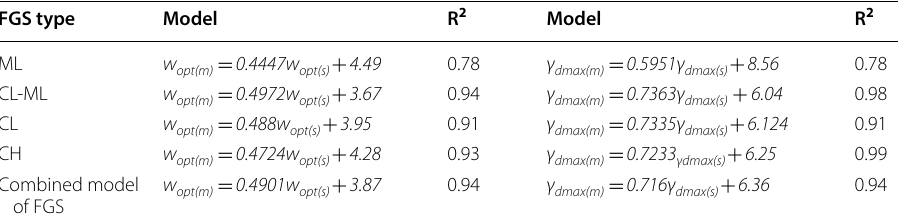
and γ ) opt(m) dmax(m) and γ ) opt(s) dmax(s)